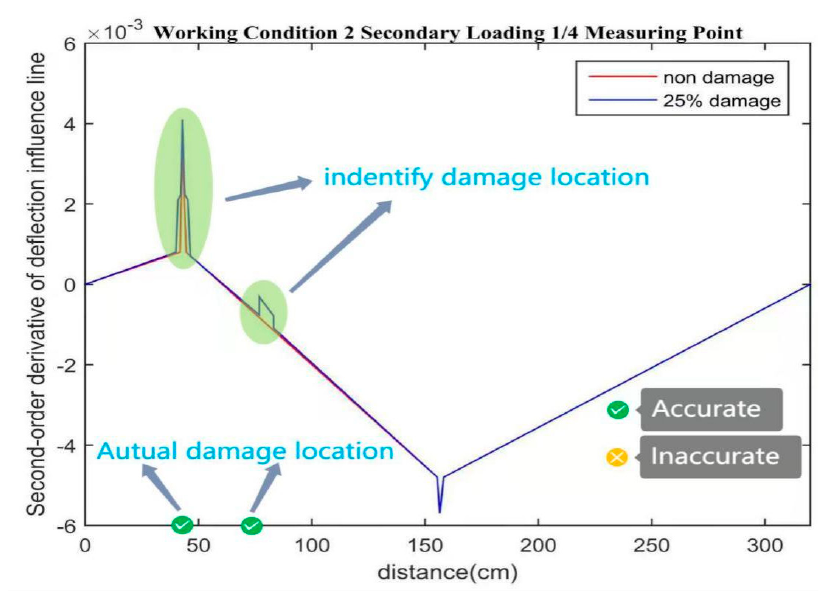
Figure 31. The second derivative of deflection influence line at 25/100 measuring point of the first span following work condition 5.